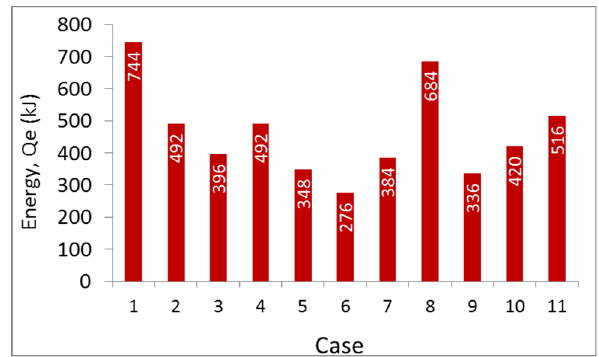
Figure 18. Consumed electrical energy of pump HP2 for the heat exchanger process.